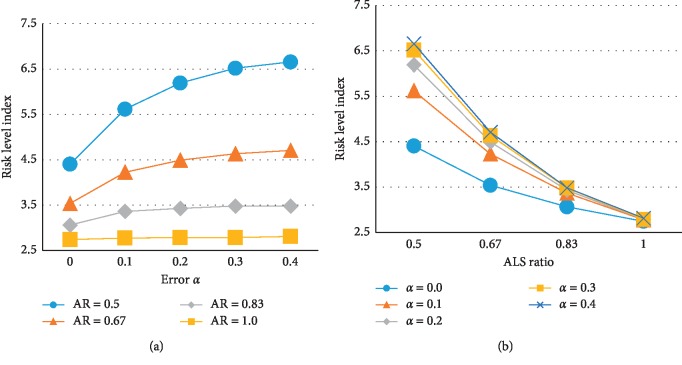
Interaction effect of ALS ratio and error α on the risk level index.